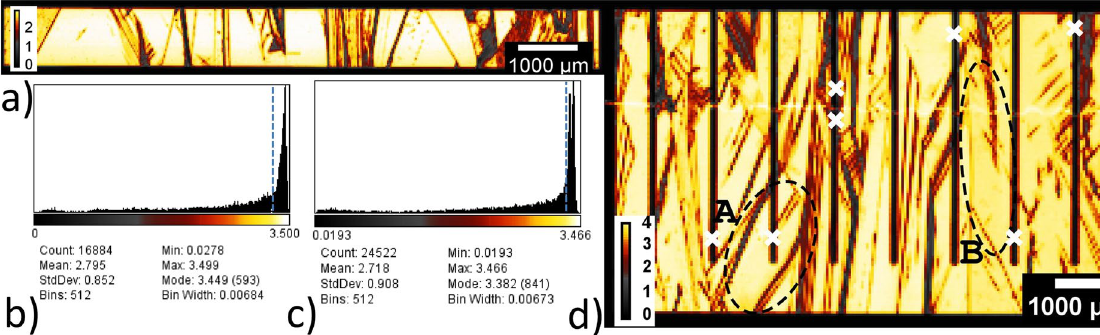
Figure 4. ( a , d ) LBIC recordings ( λ = 638 nm) and ( b , c ) histogram of all measured pixel values. ( a , b ) FEC structure (25 μ m step), ( c , d ) IBC cell (50 μ m step). Areas of reduced collection stem from absorber contact area (regular pattern) or GB and dislocations. The bright line at about two thirds height of IBC image ( d ) is a measurement artifact from an irregularity in the glass not affecting performance. White crosses mark locations where local effective diffusion lengths were fitted from line-scans. Dashed ellipses mark areas for comparison to EL and microscope images in Fig. 6. Values above blue dashed lines in ( b , c ) mark values that were used for current loss evaluation.